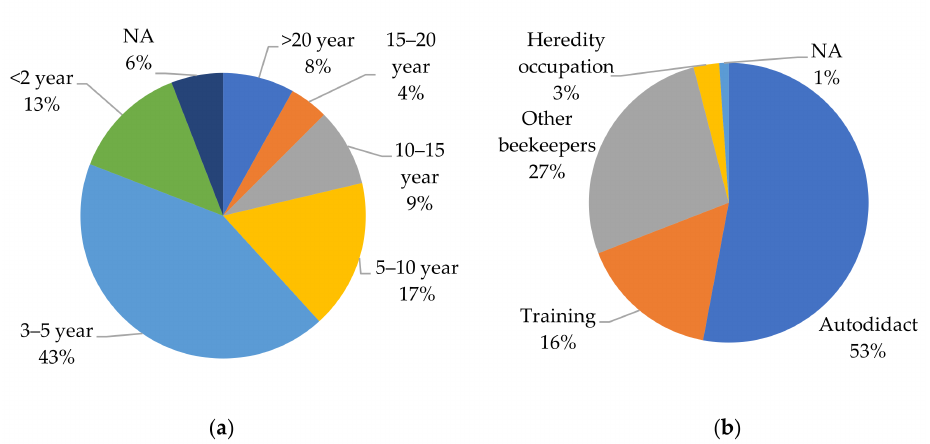
Figure 3. Experience as beekeepers based on ( a ) length of time as beekeepers and ( b ) acquiring knowledge of rearing